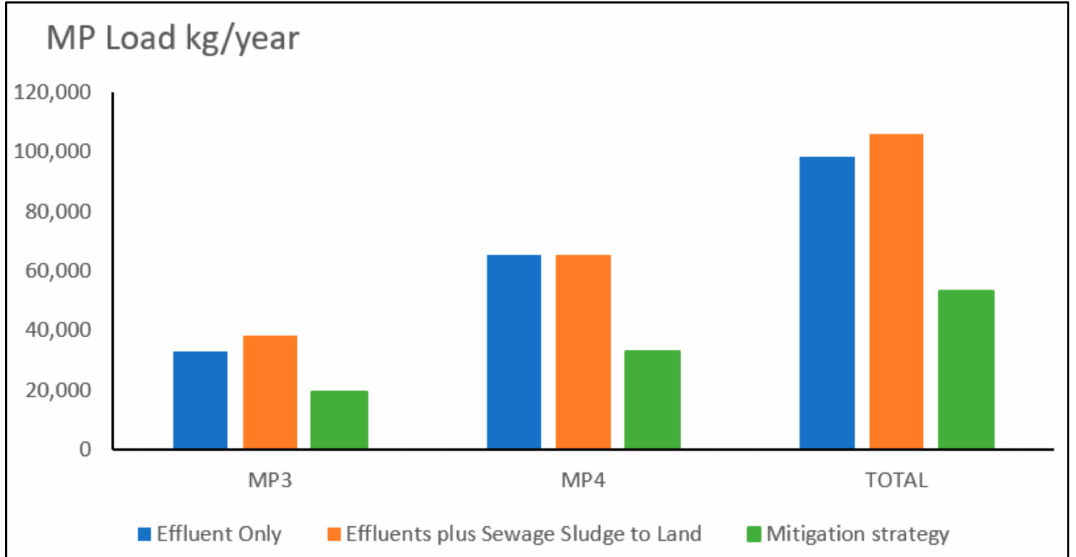
Figure 5. Microplastic Loads at Kingston moving from freshwater River Thames to the estuary